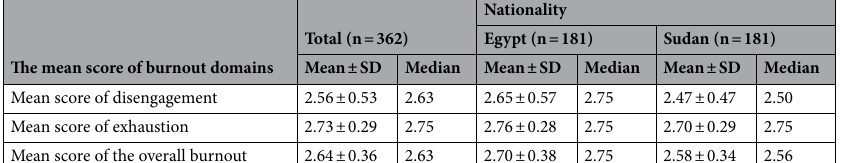
The mean score of burnout domains